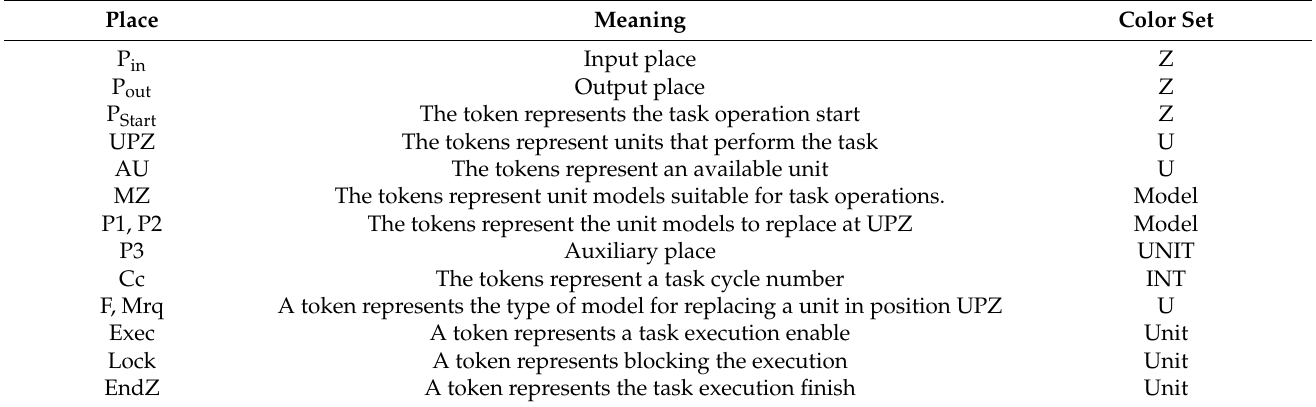
Table A1. Places of module ZExec.